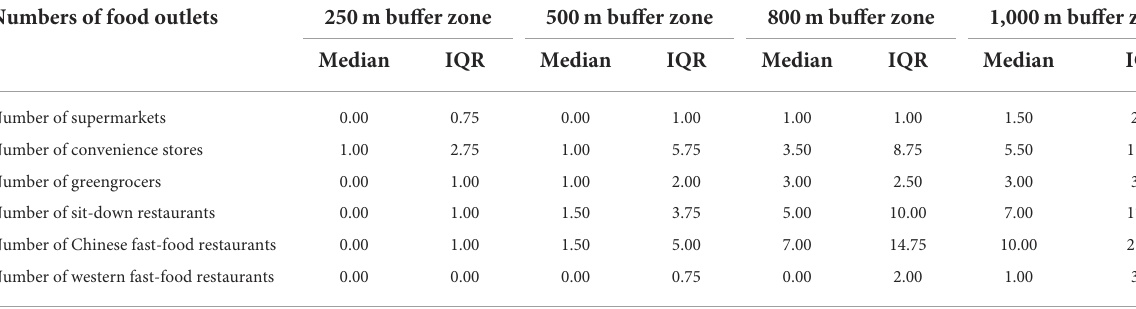
TABLE 3 Participants’ neighborhood food environment density characteristics.